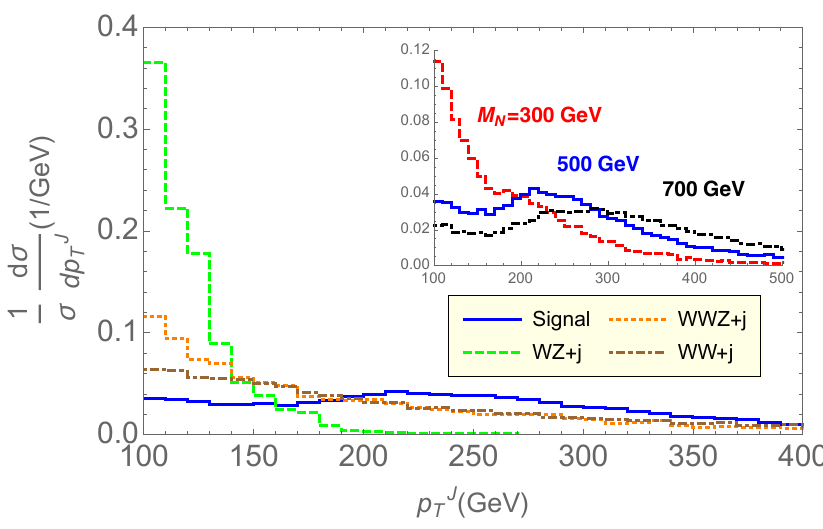
Figure 4 . Normalised di(cid:11)erential distributions as a function of fat-jet (J) transverse momentum, again after the application of the basic selection cuts. M N = 500 GeV distribution with all dominant backgrounds are shown along with an inset showing the M N = 300 ; 500 and 700 GeV cases.